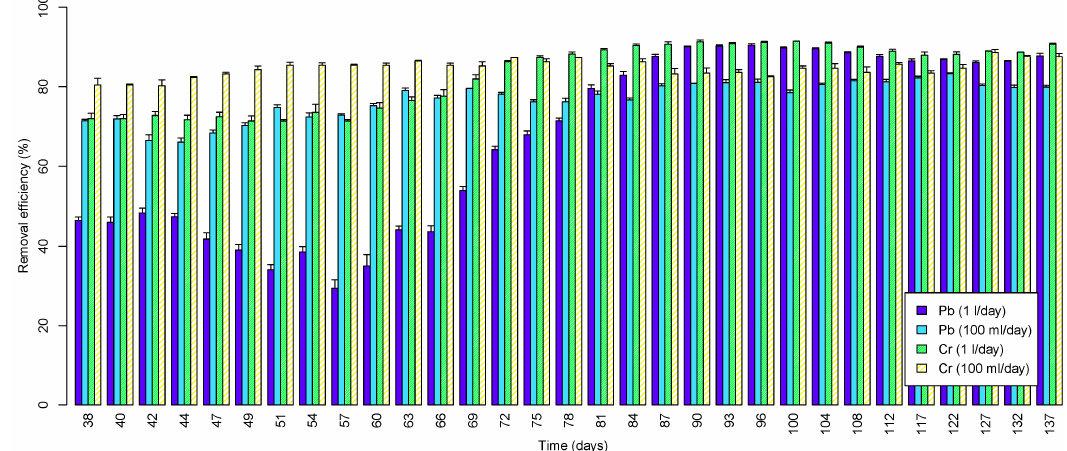
Figure 4. Pb and Cr removal efficiency (%) using spent Agaricus bisporus as a function of reactor operation time.